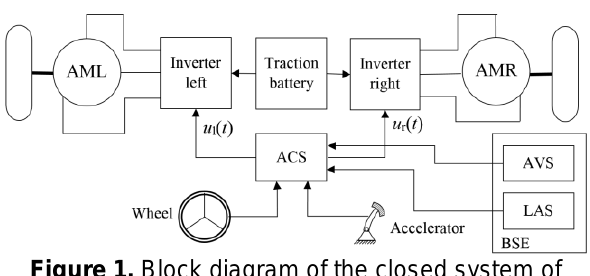
Figure 1. Block diagram of the closed system of stabilization of the moving bus: AML, AMR – AM right and left, respectively; ACS – automatic control system; BSE – block of sensing elements; AVS – angular velocity sensor (gyro); LAS – linear acceleration sensor The steering wheel, accelerator pedal, and block of sensing elements BSE give signals to the ACS unit.